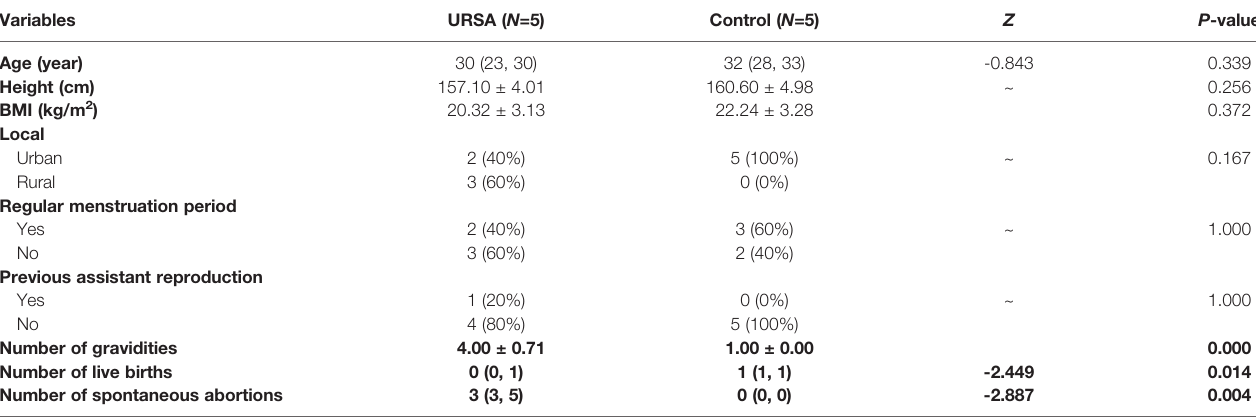
TABLE 1 | Clinical features of URSA patients and normal control women with lncRNA microarray analysis (mean ± SD or number/percentage or median with range (minimum, maximum)).